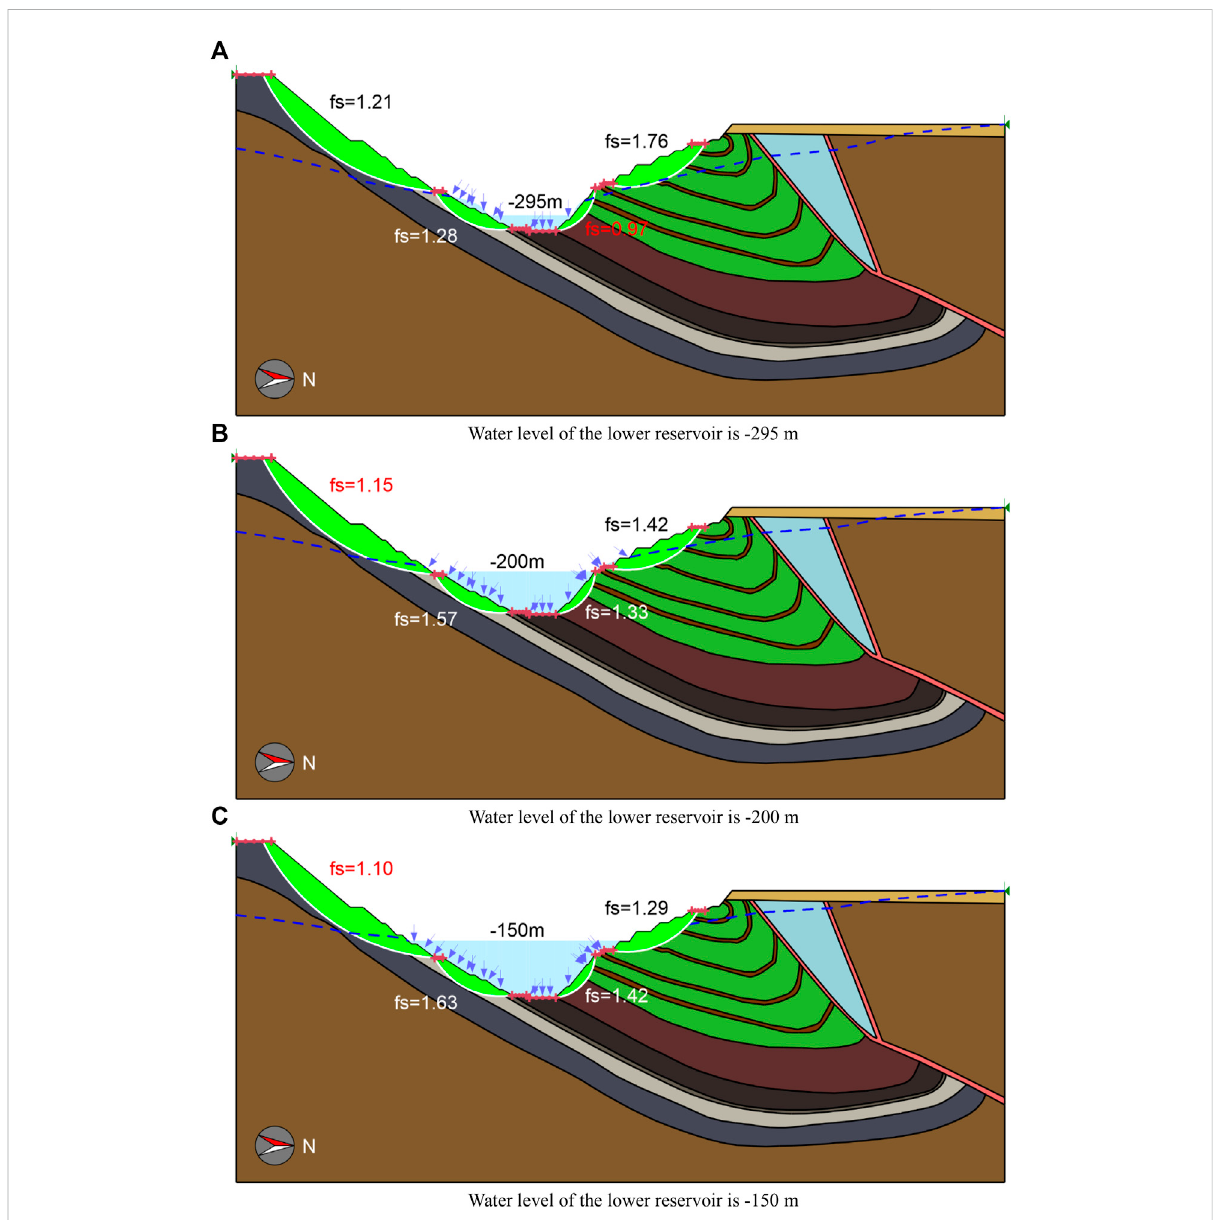
FIGURE 10 Slopestabilityanalysesunderdifferentwaterlevels. (A) Waterlevelofthelowerreservoiris − 295m. (B) Waterlevelofthelowerreservoiris − 200 m. (C) Water level of the lower reservoir is − 150